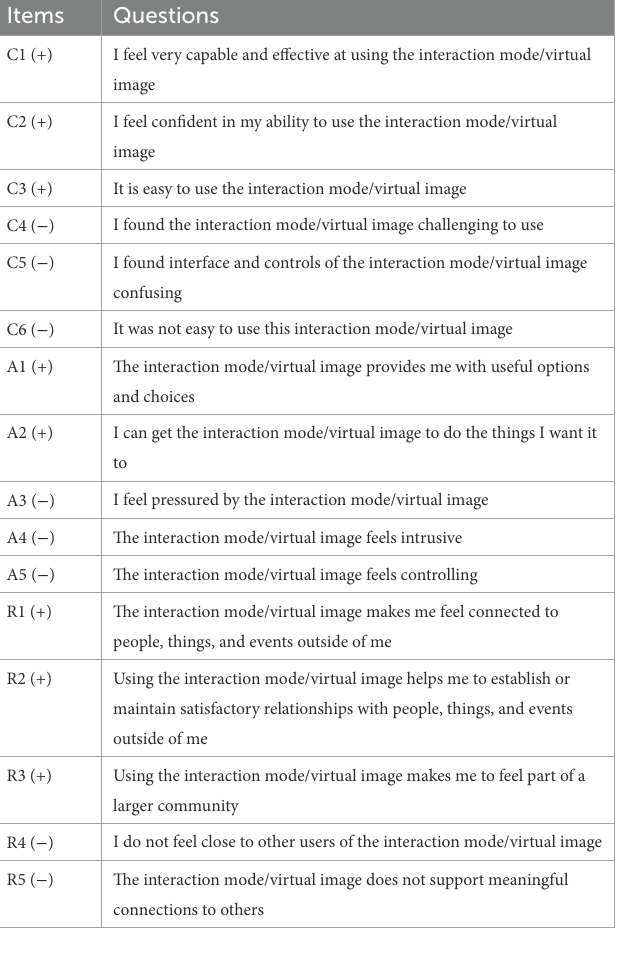
TABLE 3 The questions of the self-determination theory scale (Peters et al., 2018). Items